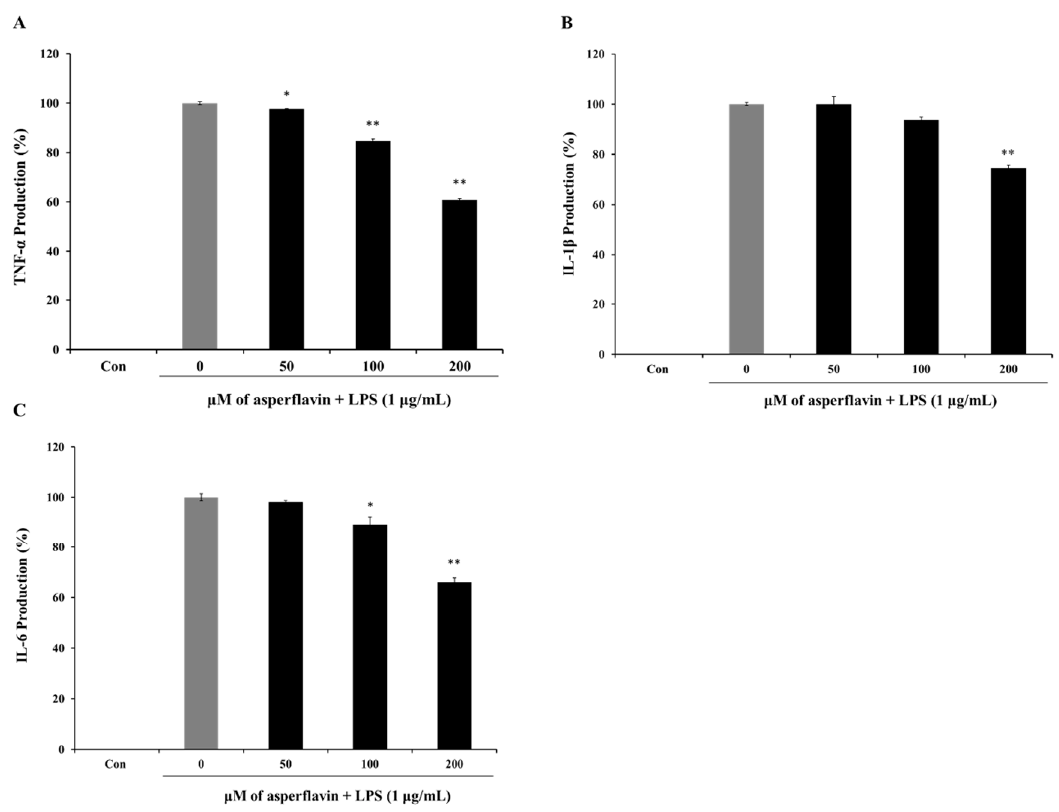
Figure 7. Inhibitory effects of asperflavin on TNF- α ( A ); IL-1 β ( B ) and IL-6 ( C ) production in LPS-stimulated RAW 264.7 cells. The production of TNF- α was assayed in the culture medium of cells stimulated by LPS (1 μ g/mL) for 24 h in the presence of asperflavin (50, 100, and 200 μ M). Supernatants were collected, and the TNF- α , IL-1 β and IL-6 production in the supernatants were determined by ELISA. Each value indicates the mean ± S.D. and is representative of results obtained from three independent experiment. * p < 0.05 and ** p < 0.01 indicate significant differences from the LPS-stimulated group.